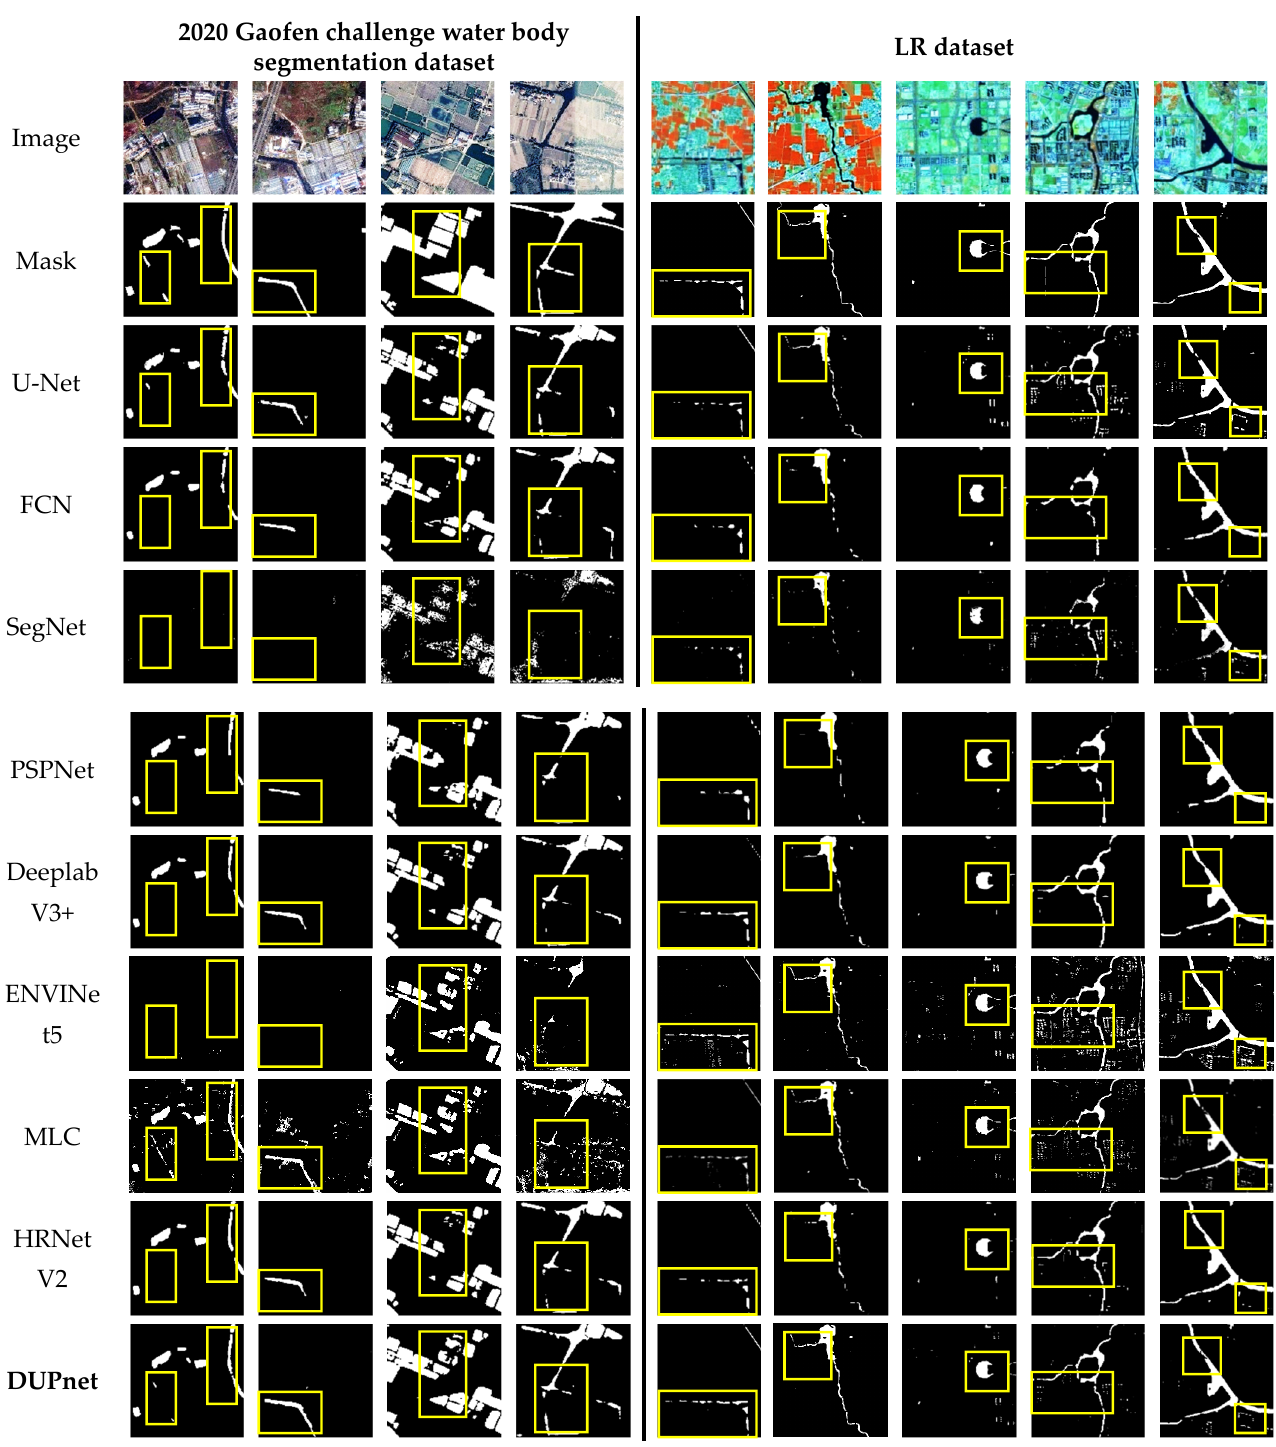
Figure 13. Qualitative evaluation with state-of-the-art methods in small bodies of water on the 2020 Gaofen challenge water body segmentation dataset and the LR dataset.